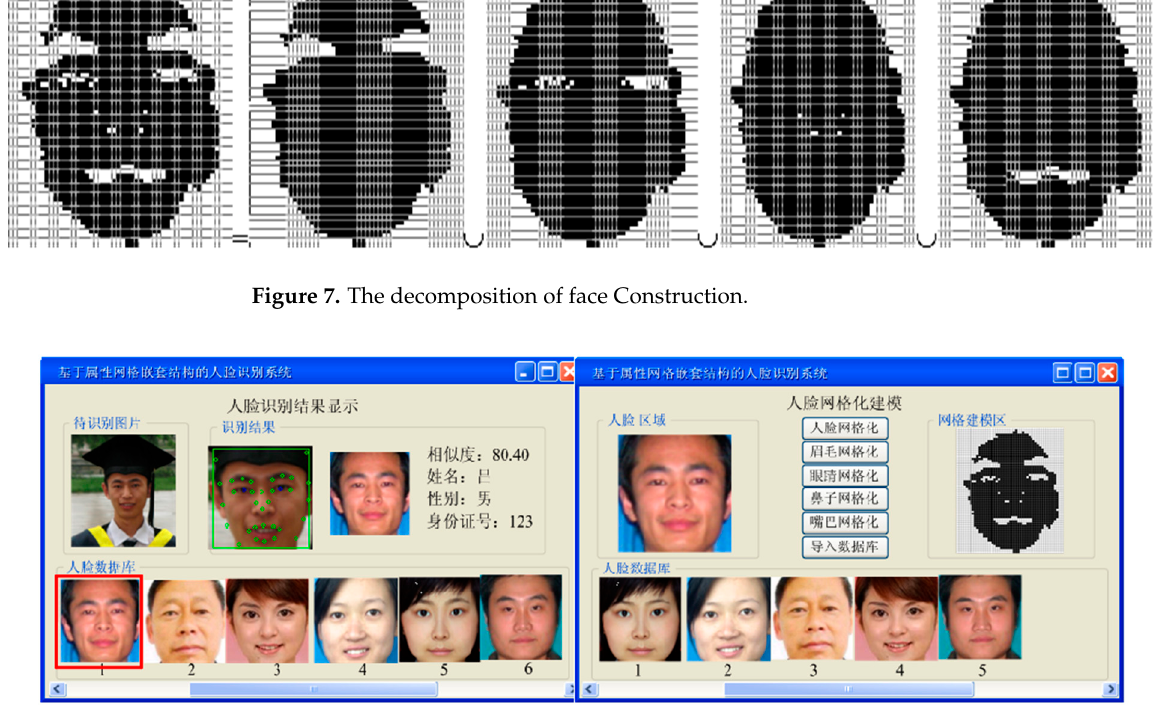
Figure 8. The decomposition of face construction.